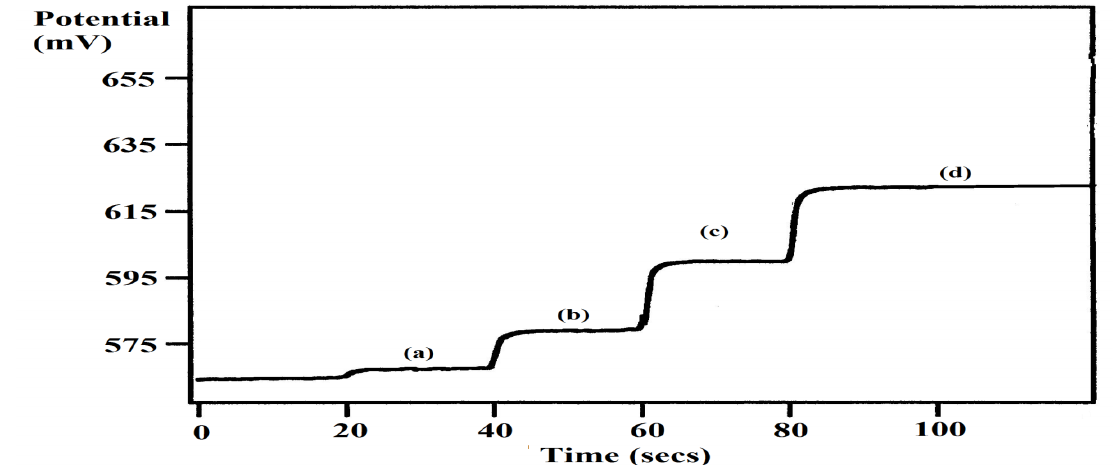
Figure 9. Potentiograms obtained for the analysis of Amoxycillin tablet with the PTy- PNCnase biosensor. Measurement solution was 0.01 mM buffer with the addition of: penicillin